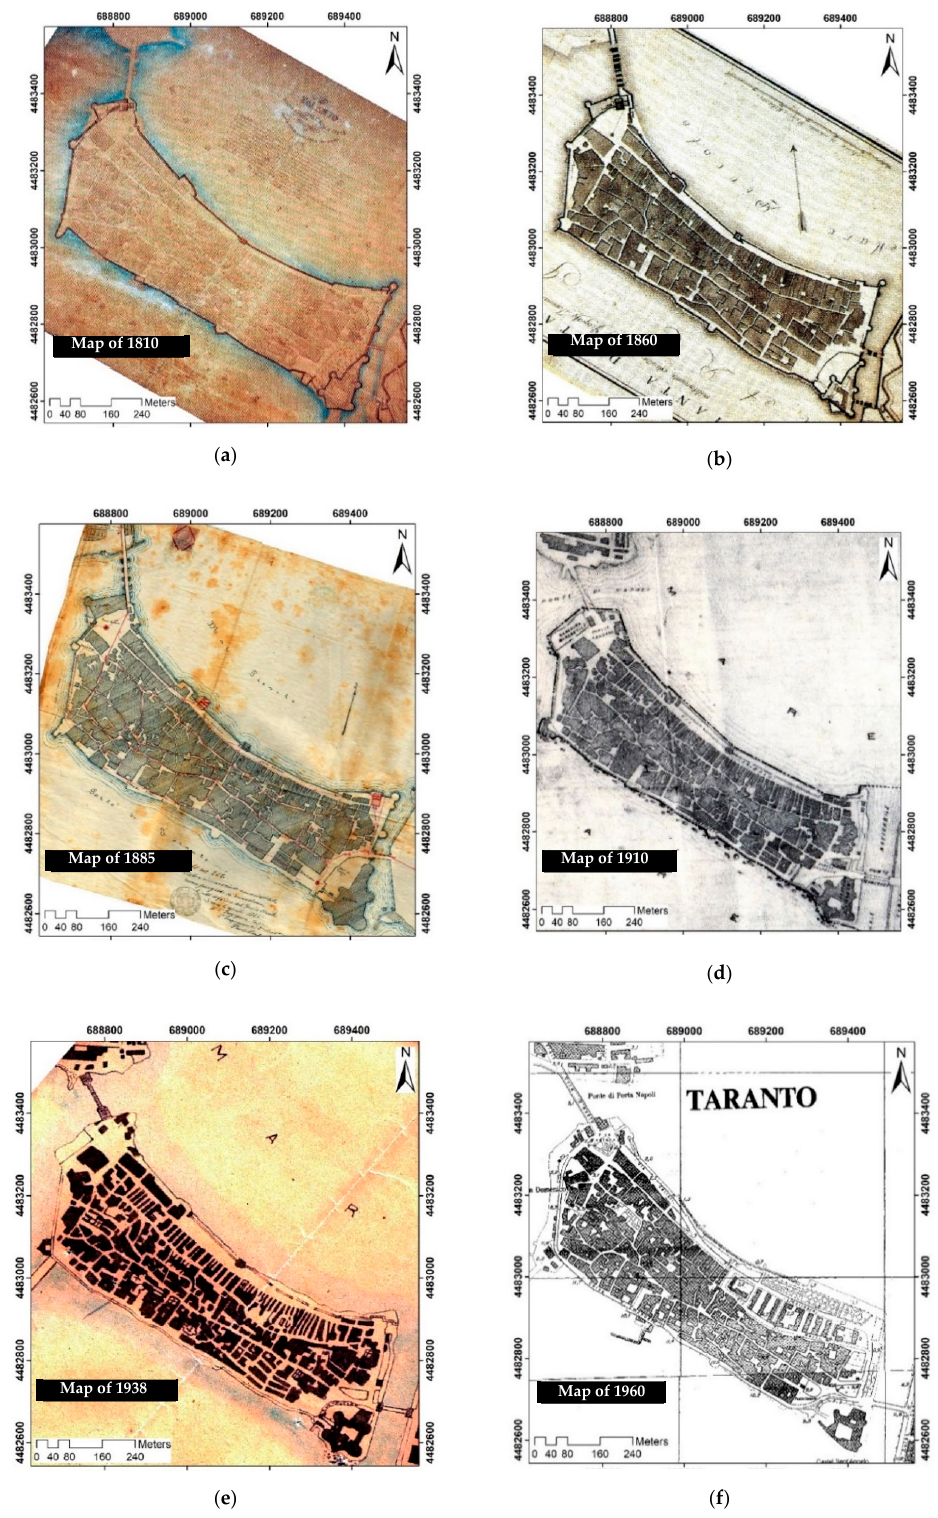
Figure 10. Georeferencing of historical maps: ( a ) map of 1810, ( b ) 1860, ( c ) 1885, ( d ) 1910, ( e ) 1938, ( f ) 1960.